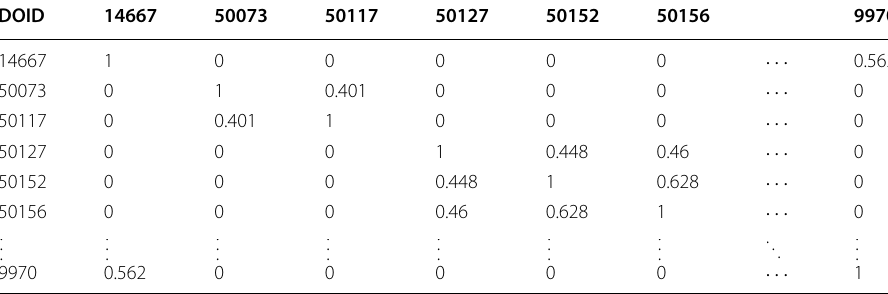
Rows and columns show the disease represented by DOID. The value in the matrix cell is the level of similarity. The higher the more similar